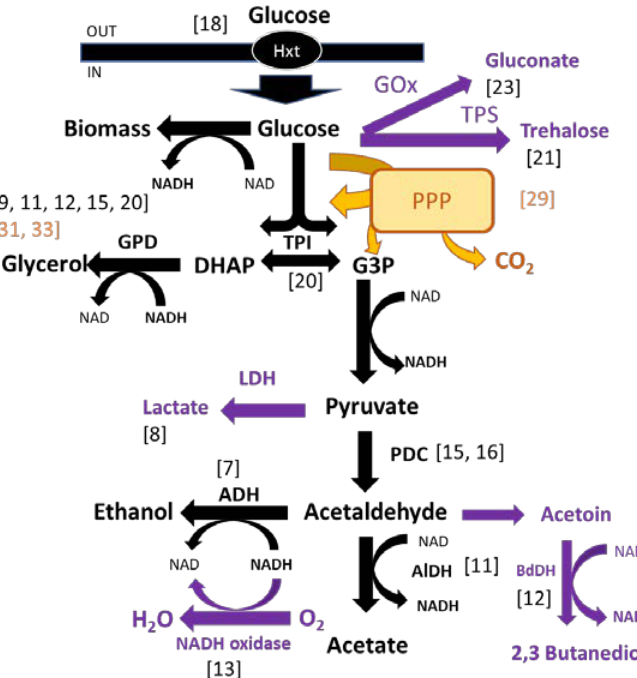
Figure 1. Diagram of the alcoholic fermentation pathway with indications of the steps affected by the different genetic modifications assayed to lower ethanol yields. References in black: genetic engineering. References in yellow: adaptive evolution. Metabolites outside of the central ethanol fermentation pathway are indicated in purple.